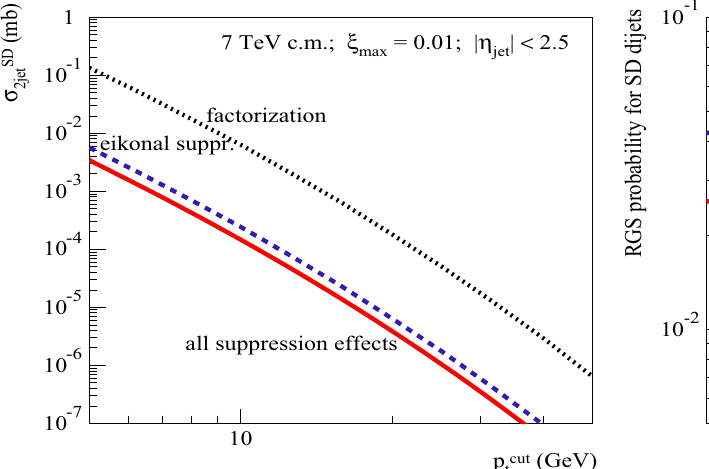
Fig. 8 Left: p cut t -dependence of the calculated SD dijet cross sections: p cut t -dependence of the corresponding RGS probabilities: